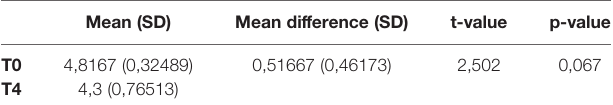
TABLE 5 | Paired samples t-test T0 – T4. Light touch test. Without pathologic fracture (n = 5). a = 0,05. Mean (SD) Mean difference (SD) t-value